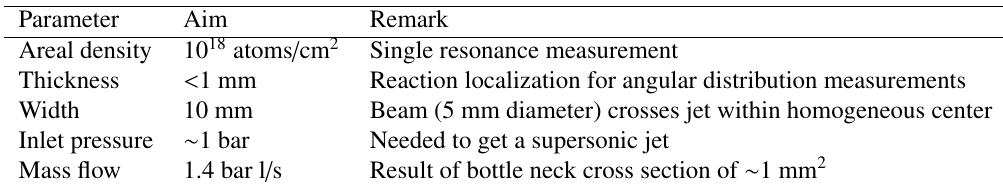
Table 1. Aimed characteristics of the gas wall